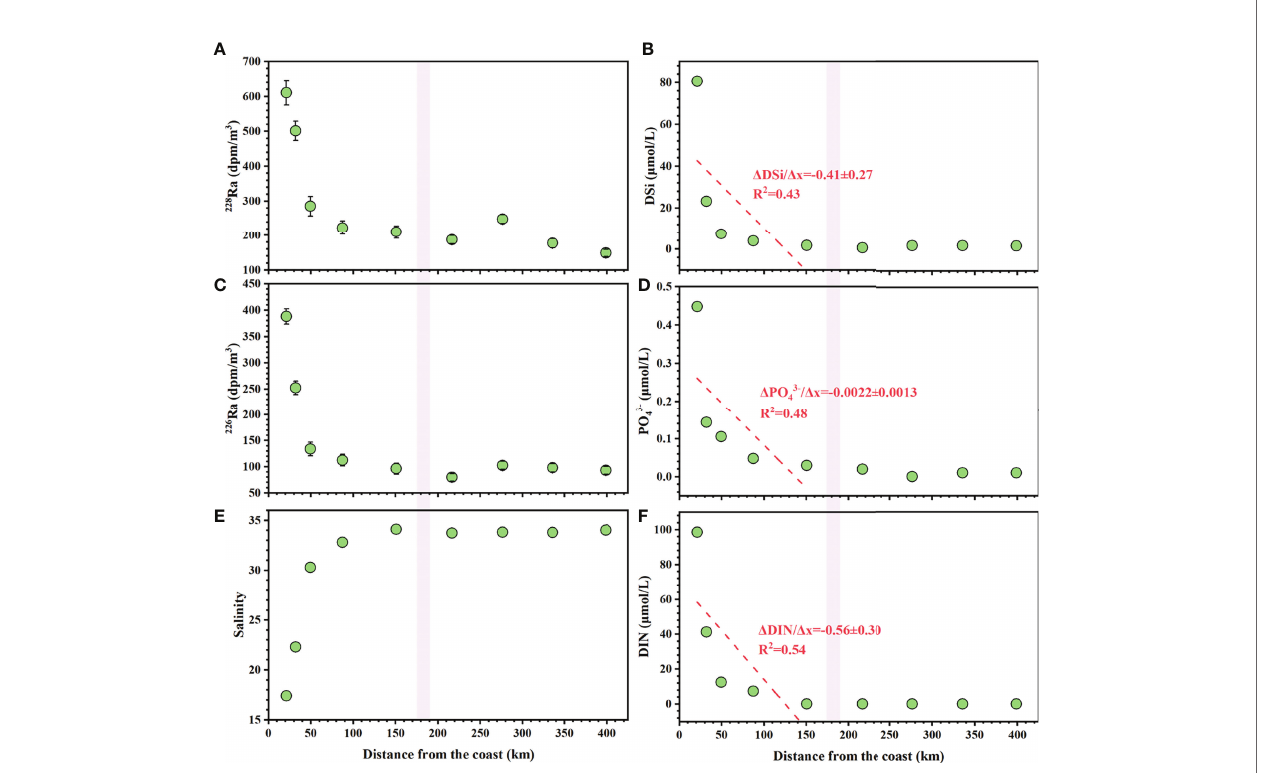
FIGURE 4 | Surface (A) salinity, (B) 226 Ra, (C) 228 Ra, (D) DIN, (E) PO 3 − 4 , and (F) DSi along the transect (stations K1 – K5 to J8 – J5) of June 2015. Dashed red lines represent the linear regression trends through the relationships between concentrations of Ra and nutrient and distance from the coast. The violet bands indicate the boundary of the shelf break, highlighted by high salinity and changing Ra and nutrient gradients. The D nutrient/ D x indicates the nutrient gradients ( m mol/km) over the distance from the